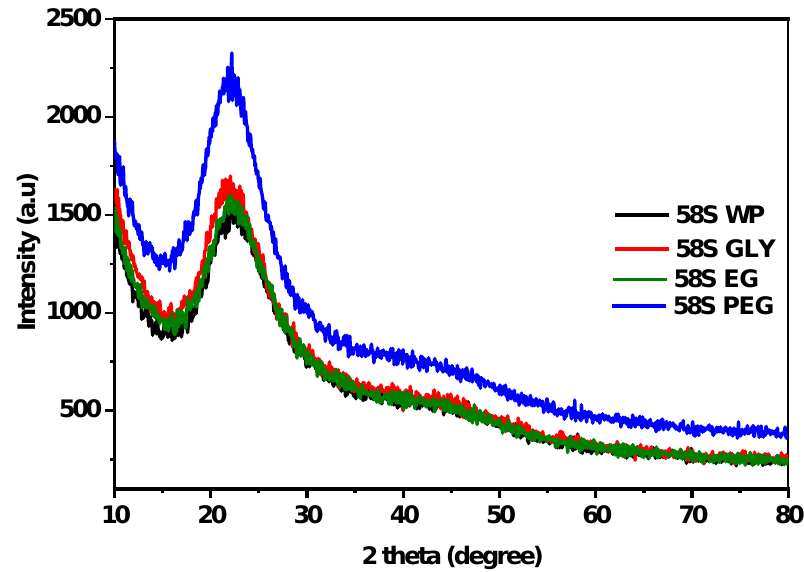
Figure 2. XRD patterns of 58S WP, 58S GLY, 58S EG, and 58S PEG powders dry at 160 ° C.